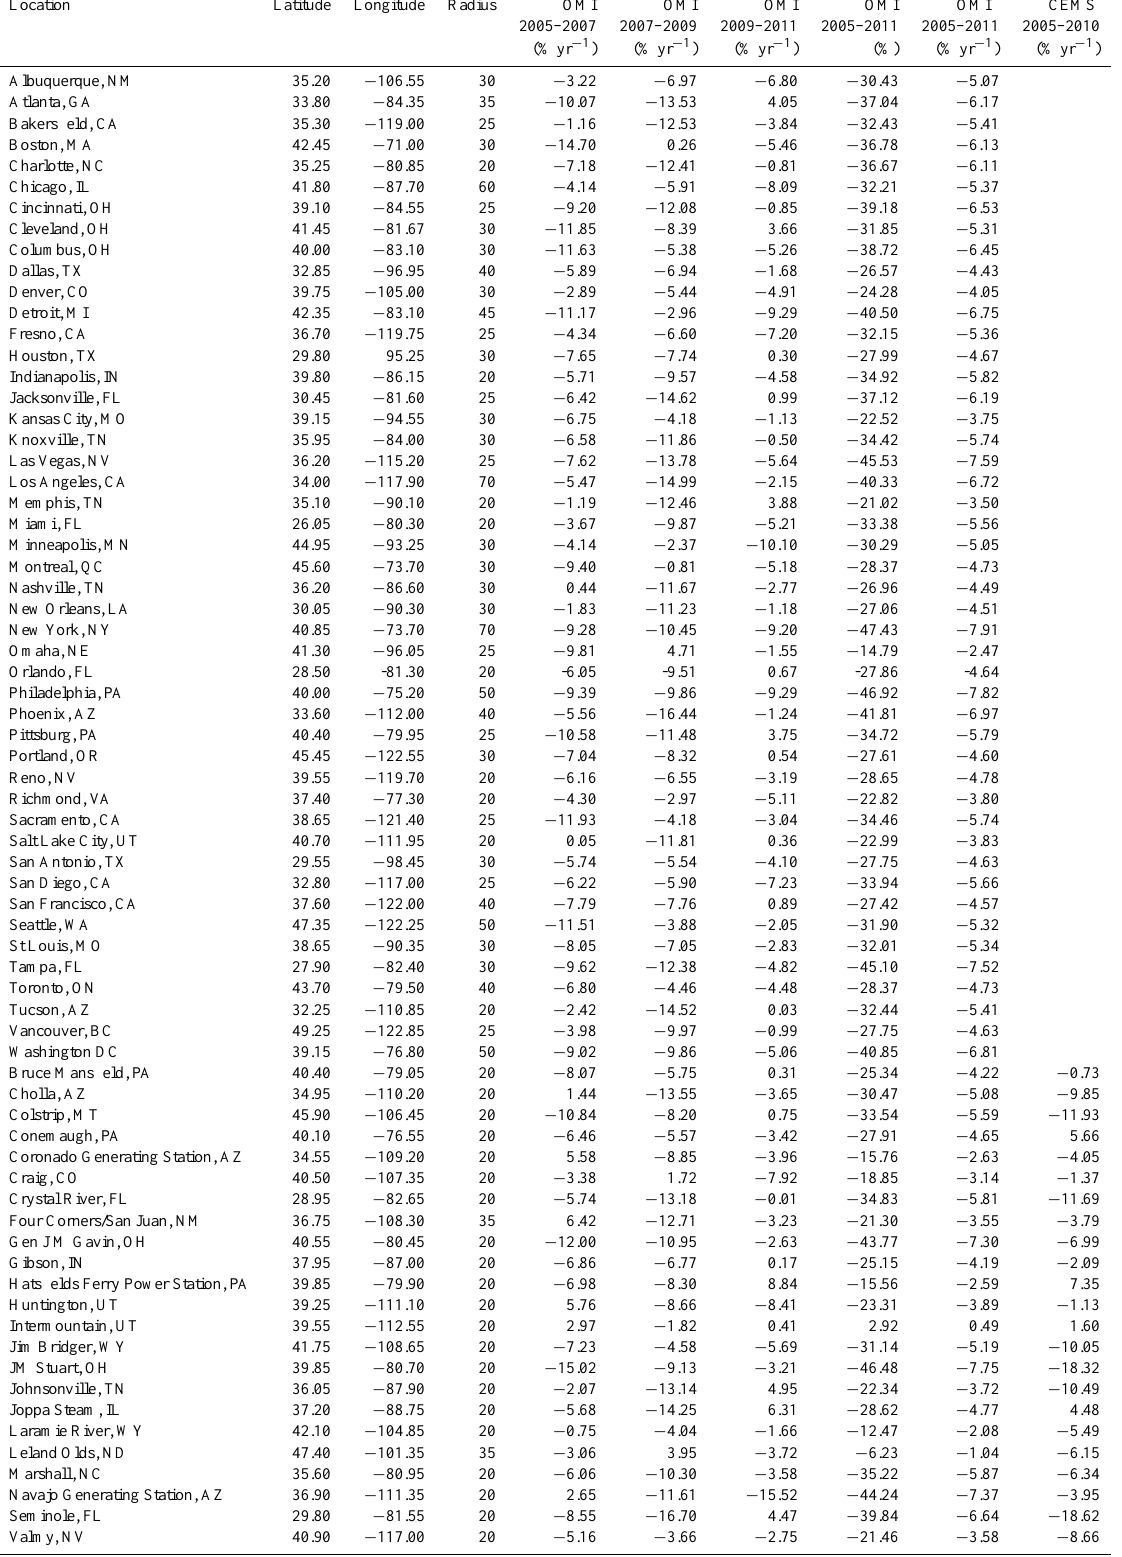
Table A1. Summary of regions evaluated in this study and the percent change in NO 2 observed by OMI and at CEMS